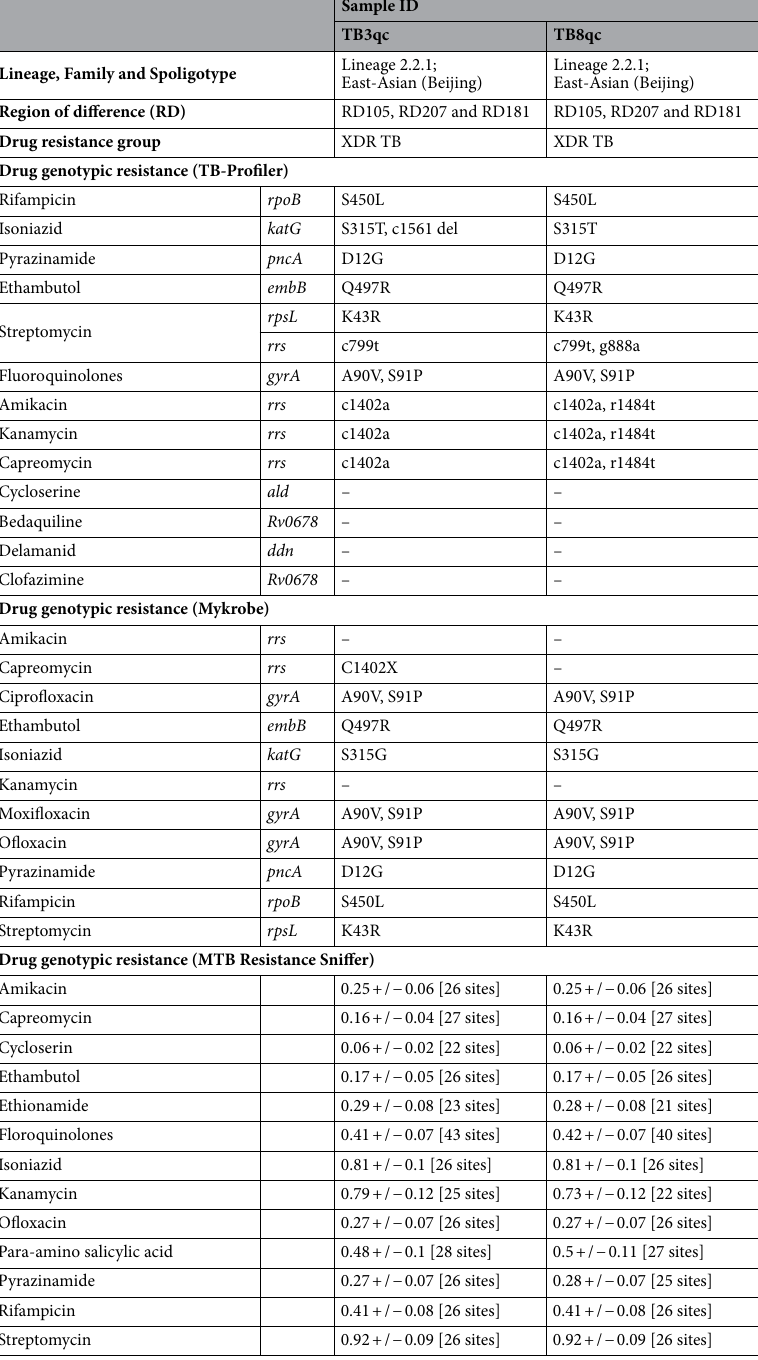
Table 2. In-silico drug-resistant analysis of MTBC samples and Lineage